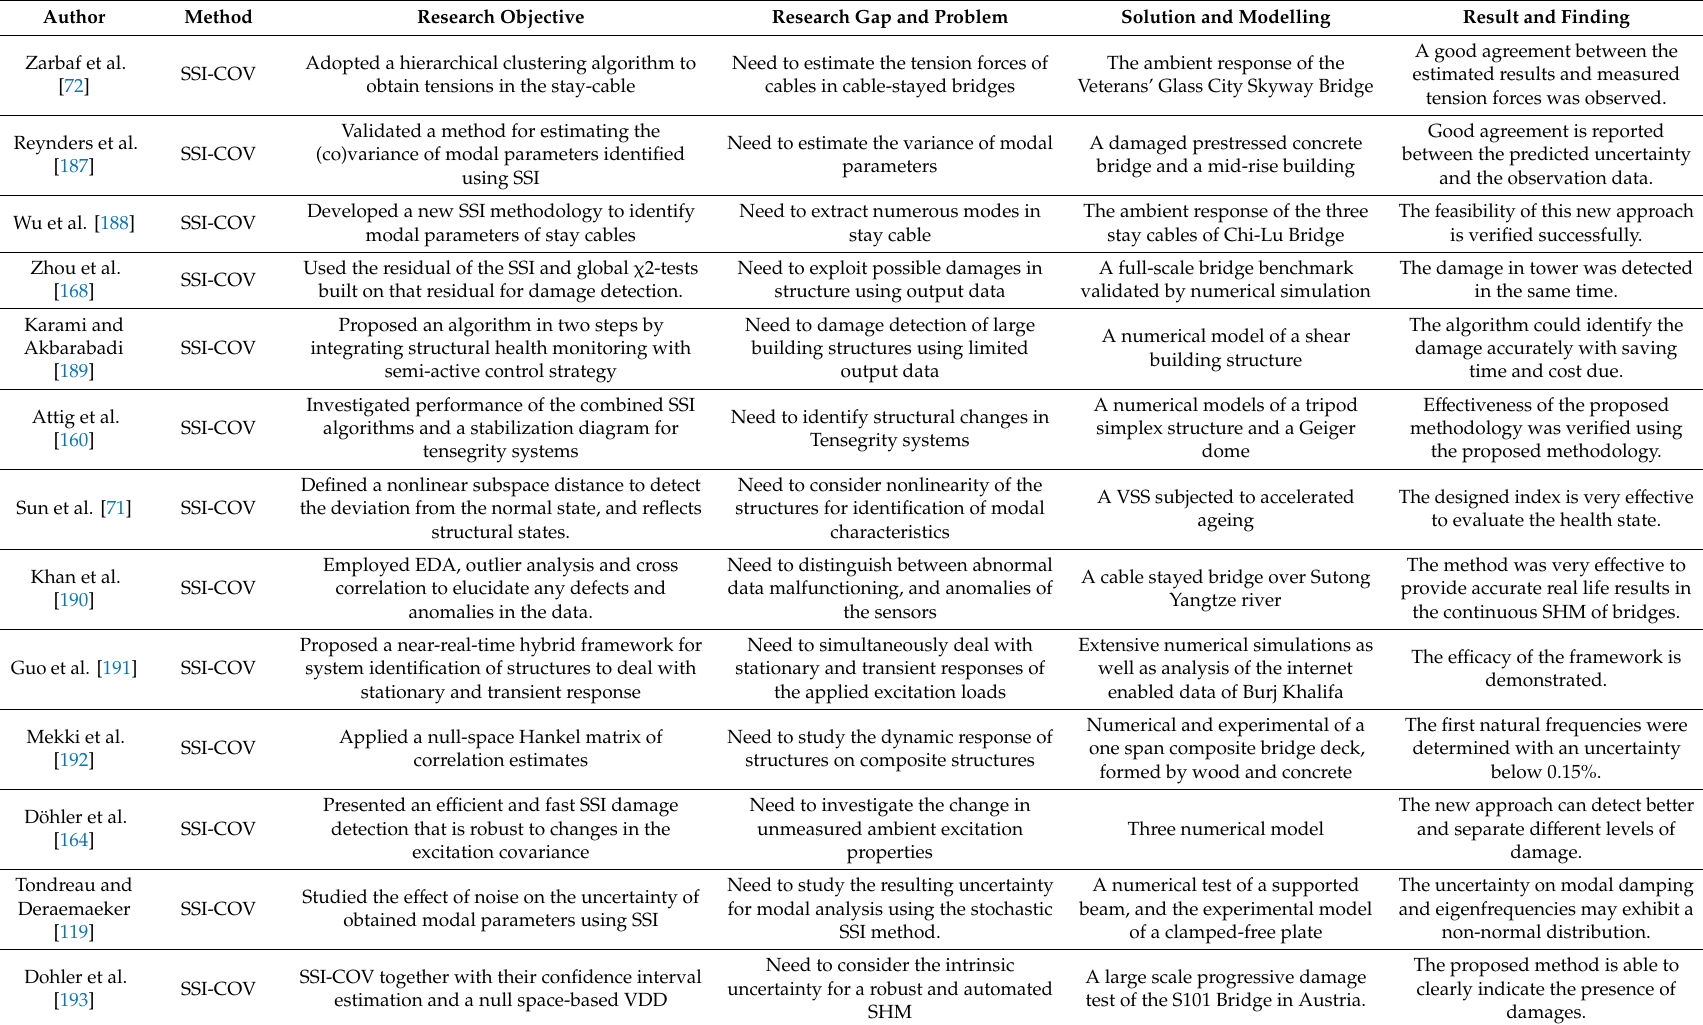
Table A2. Distribution of the papers based on SSI-COV